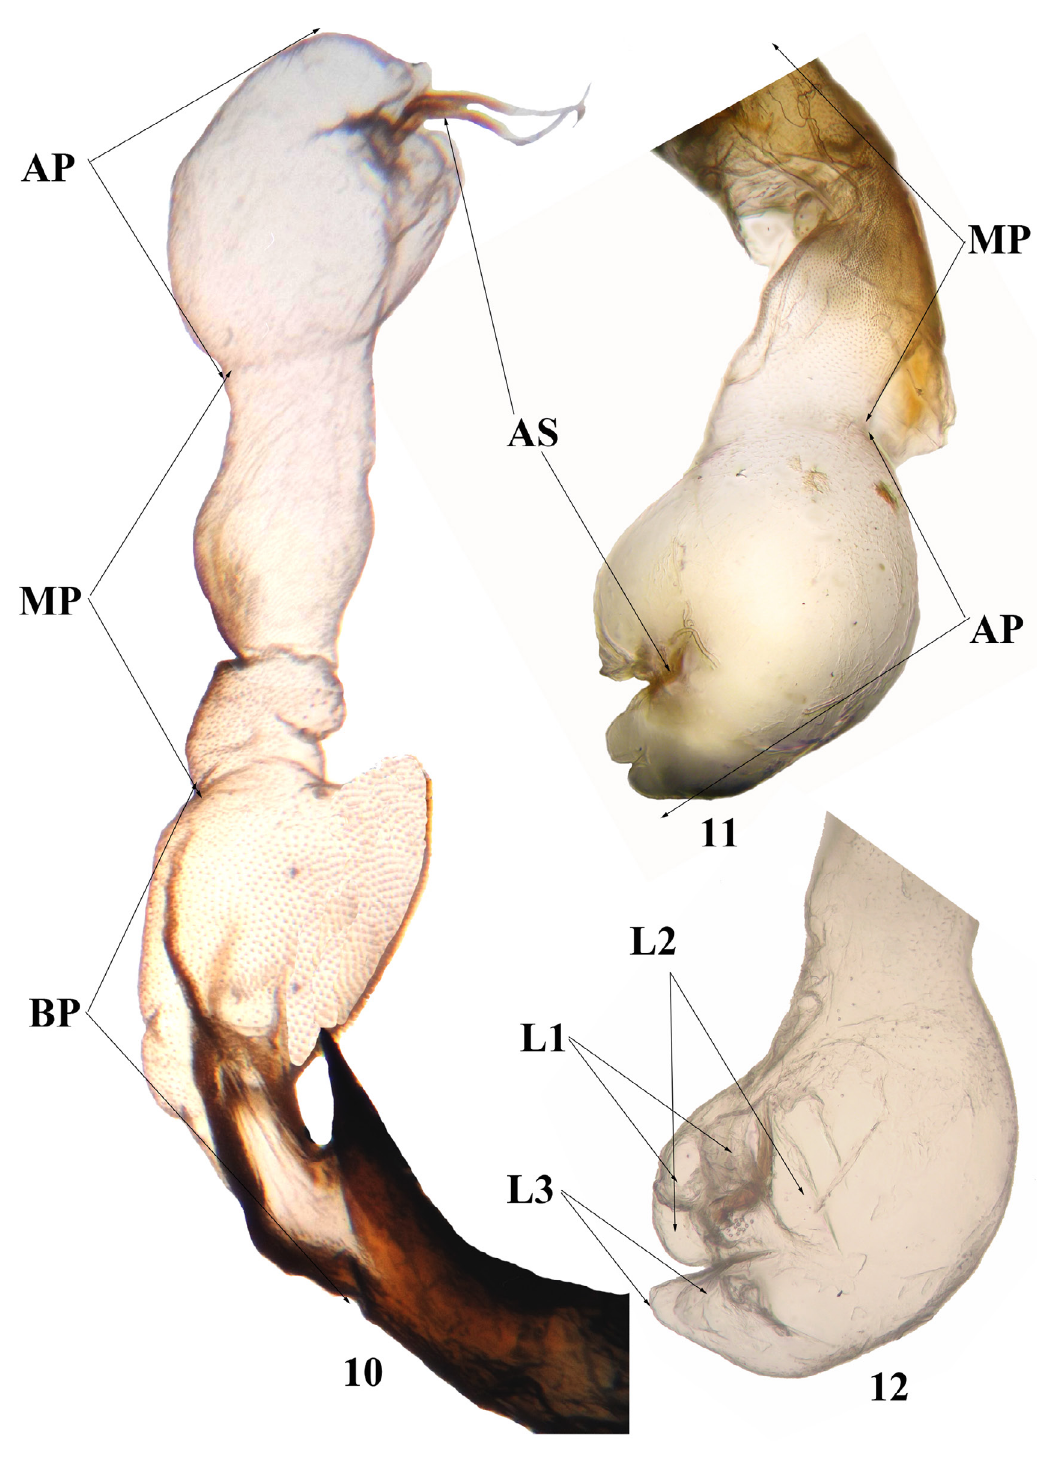
Figs 10–12. Endophallus of Fidia kanaraensis (Jacoby, 1895) comb. nov., lateral view. 10 . Endophallus, everted through apical opening or ostium. 11 . Endophallus, everted through basal opening. 12 . Apical phallomere with three pairs of lobes. Abbreviations: AP = apical phallomere; AS = apical sclerite; BP = basal phallomere; L 1 = first pair of lobes; L 2 = second pair of lobes; L 3 = third pair of lobes; MP = median